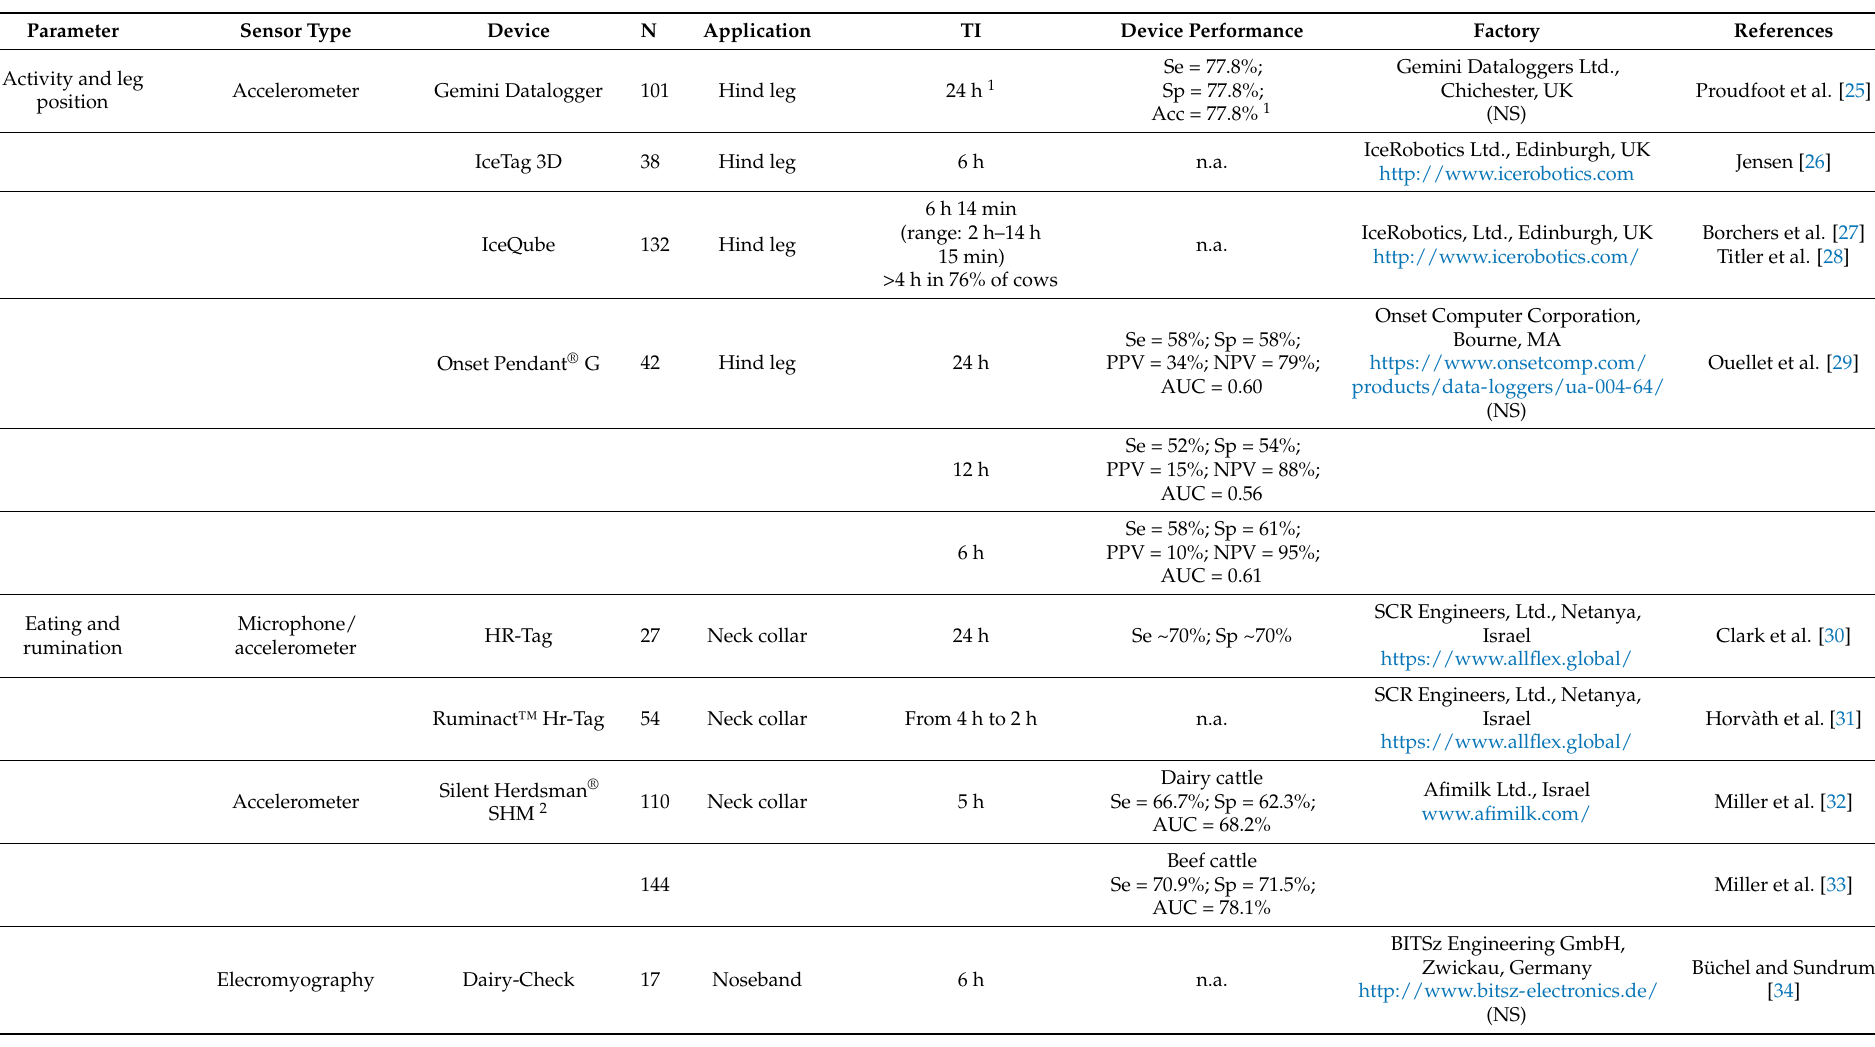
Table 1. Devices for automatic activity and feeding monitoring for calving prediction, with performance and